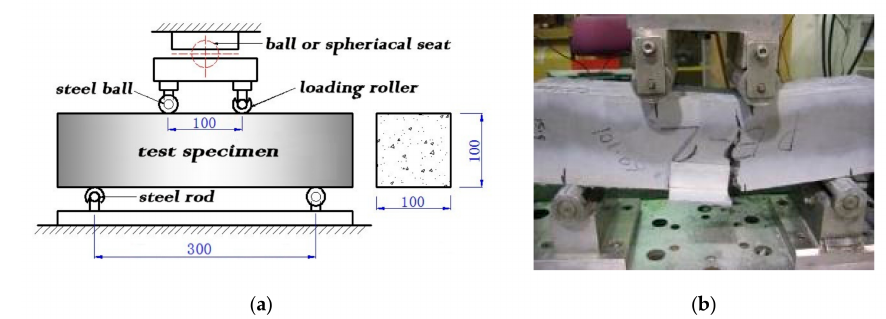
Figure 3. Experimental setup of four-point bending test: ( a ) schematic diagram; ( b ) photo of PE2 specimen under test.